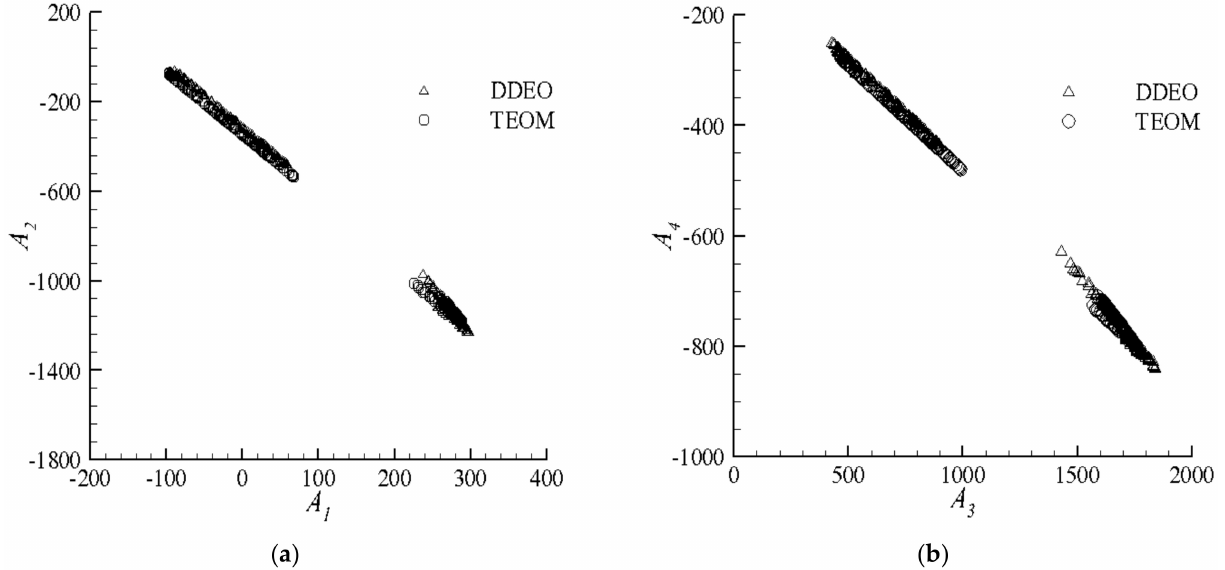
Figure 9. Comparison of the Pareto solutions: ( a ) A 1 versus A 2 ; ( b ) A 3 versus A 4